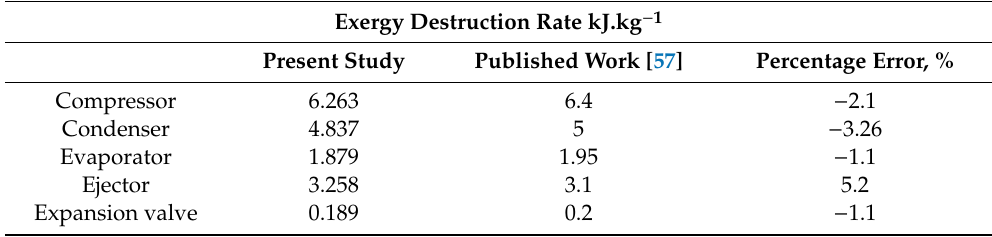
Table 6. Comparison of the exergy destruction rates with published